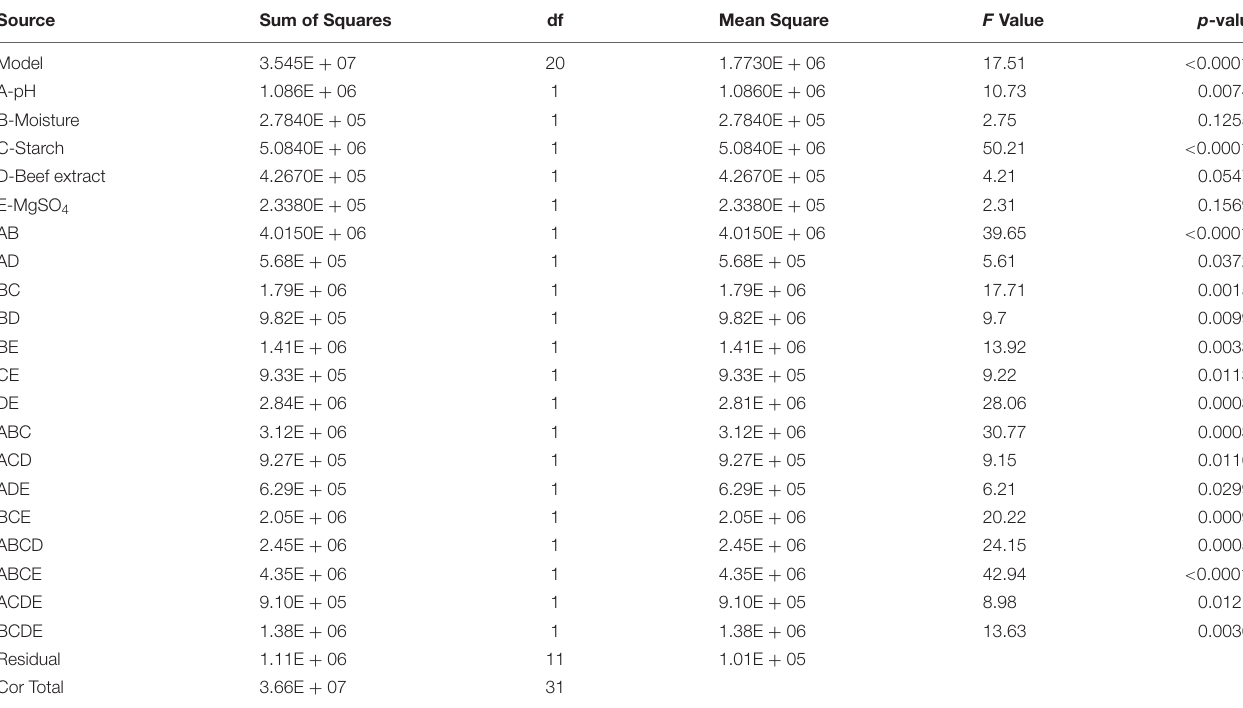
TABLE 2C | Analysis of variance for two-level full factorial design for the production of fibrinolytic enzyme. Source Sum of Squares df